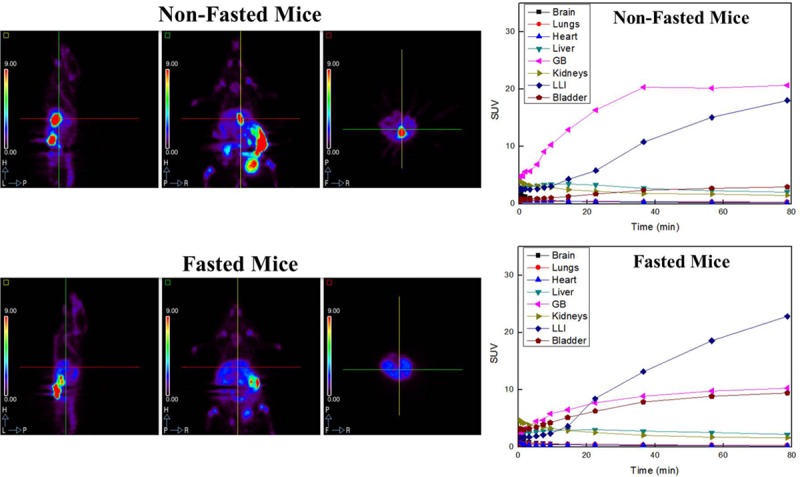
Representative whole-body biodistribution of [18F]T807 in normal mice at last time-frame post injection and non-decay-corrected time-activity curves of [18F]T807 in various organs of non-fasted mice (n = 4) and fasted mice (n = 3).